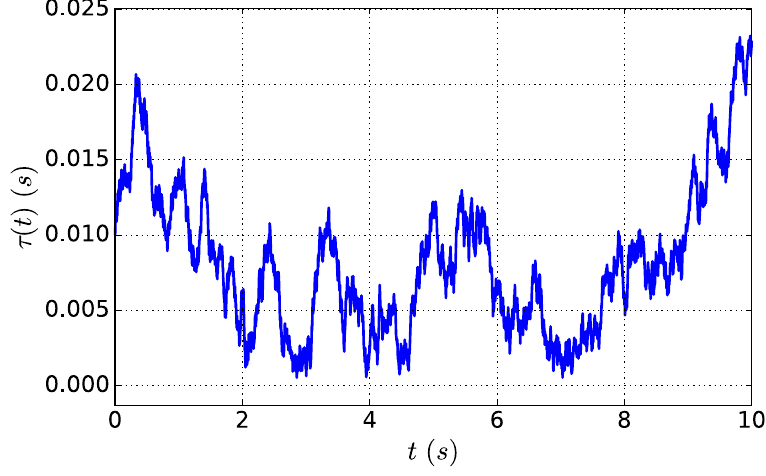
Figure 3. Time delay τ ( t ) .